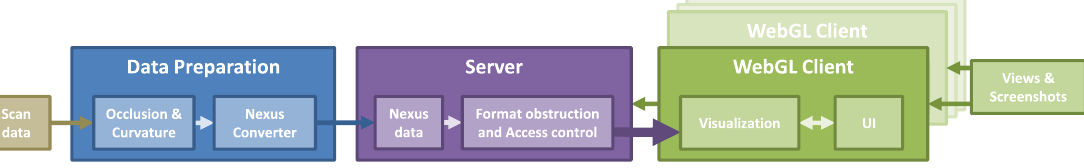
Figure 2. Outline of the viewer concept. The data preparation step extends the scan data and performs the conversion to the nexus format. The server hosts the nexus files, delivers obstructed data and performs access control. The WebGL client is responsible vor 3D visualization and providing a user interface. Sharing views and screenshots are manual collaborative features for exchange between multiple WebGL